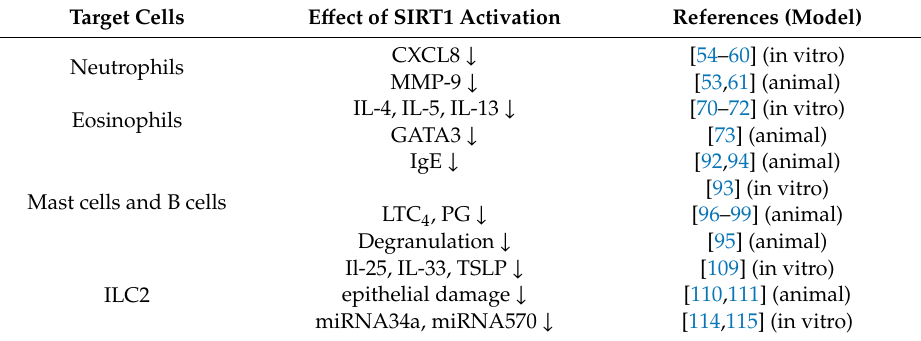
Table 1. Relationship between target cells and